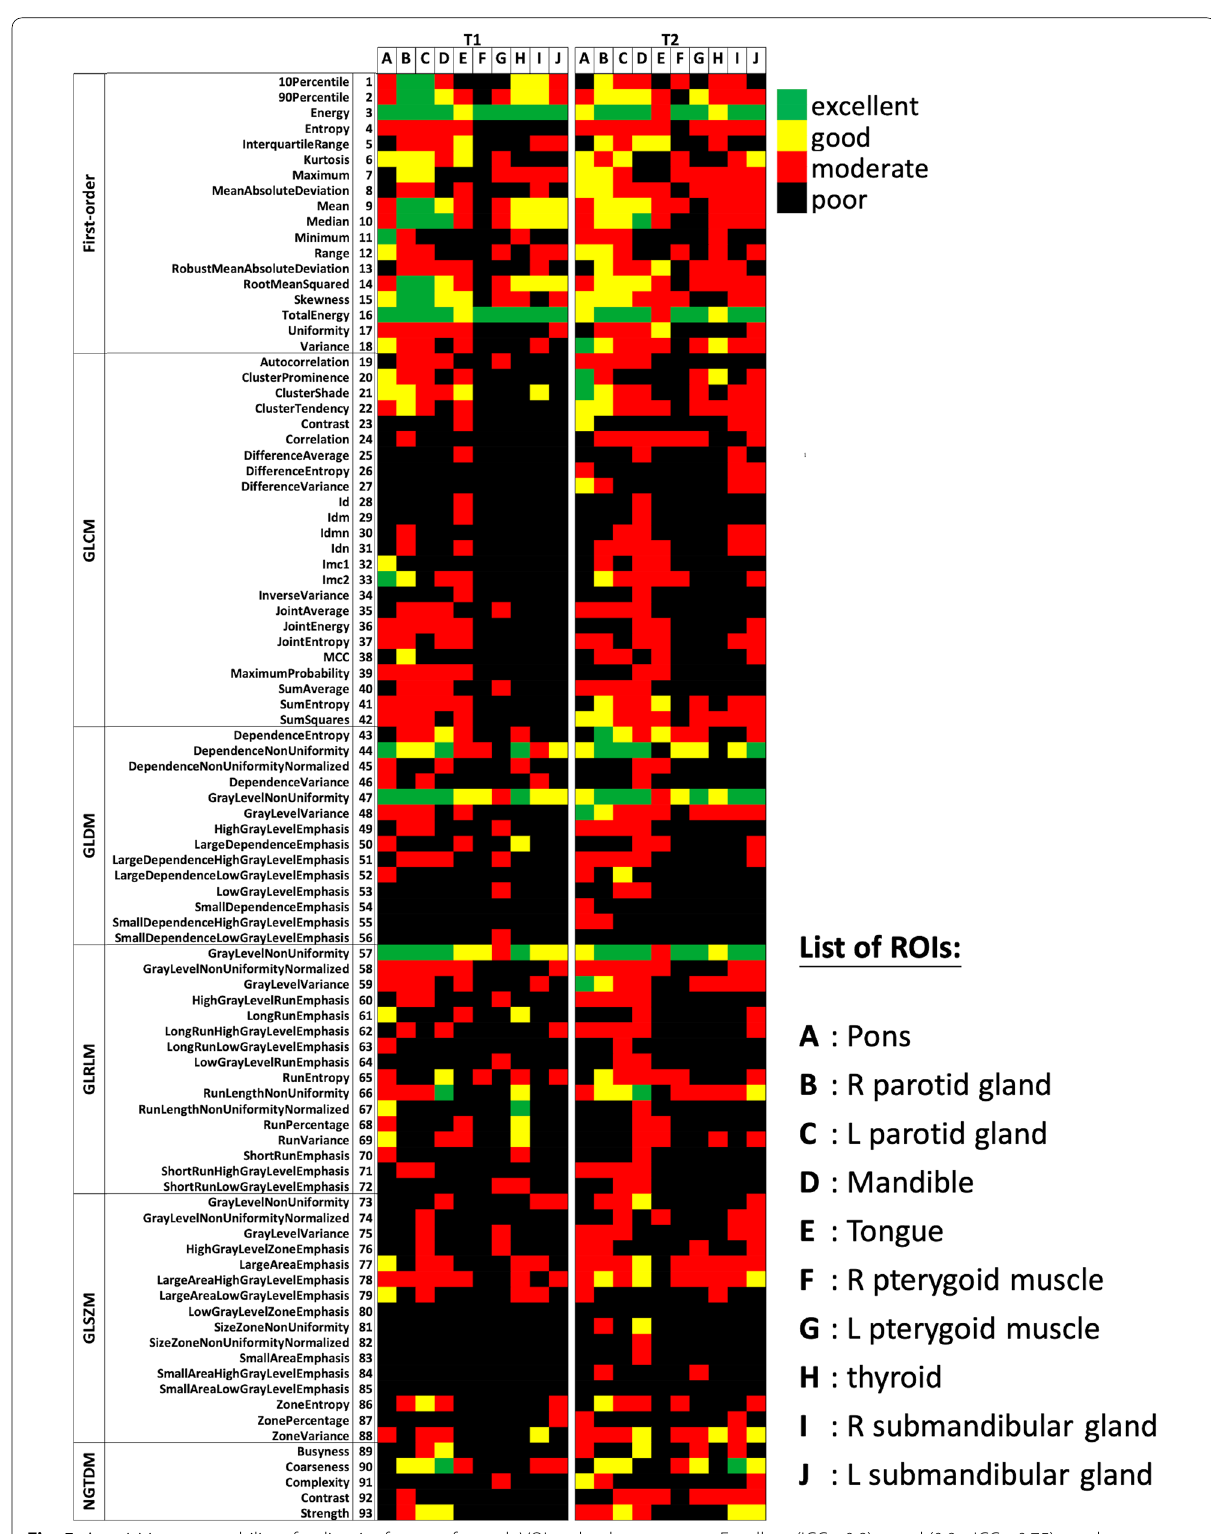
Fig. 5 Acquisition repeatability of radiomics features for each VOI and pulse sequence. Excellent (ICC > 0.9), good (0.9 > ICC > 0.75), moderate (0.75 > ICC > 0.5), and poor (ICC < 0.5) repeatability was marked by green, yellow, red, and black blocks